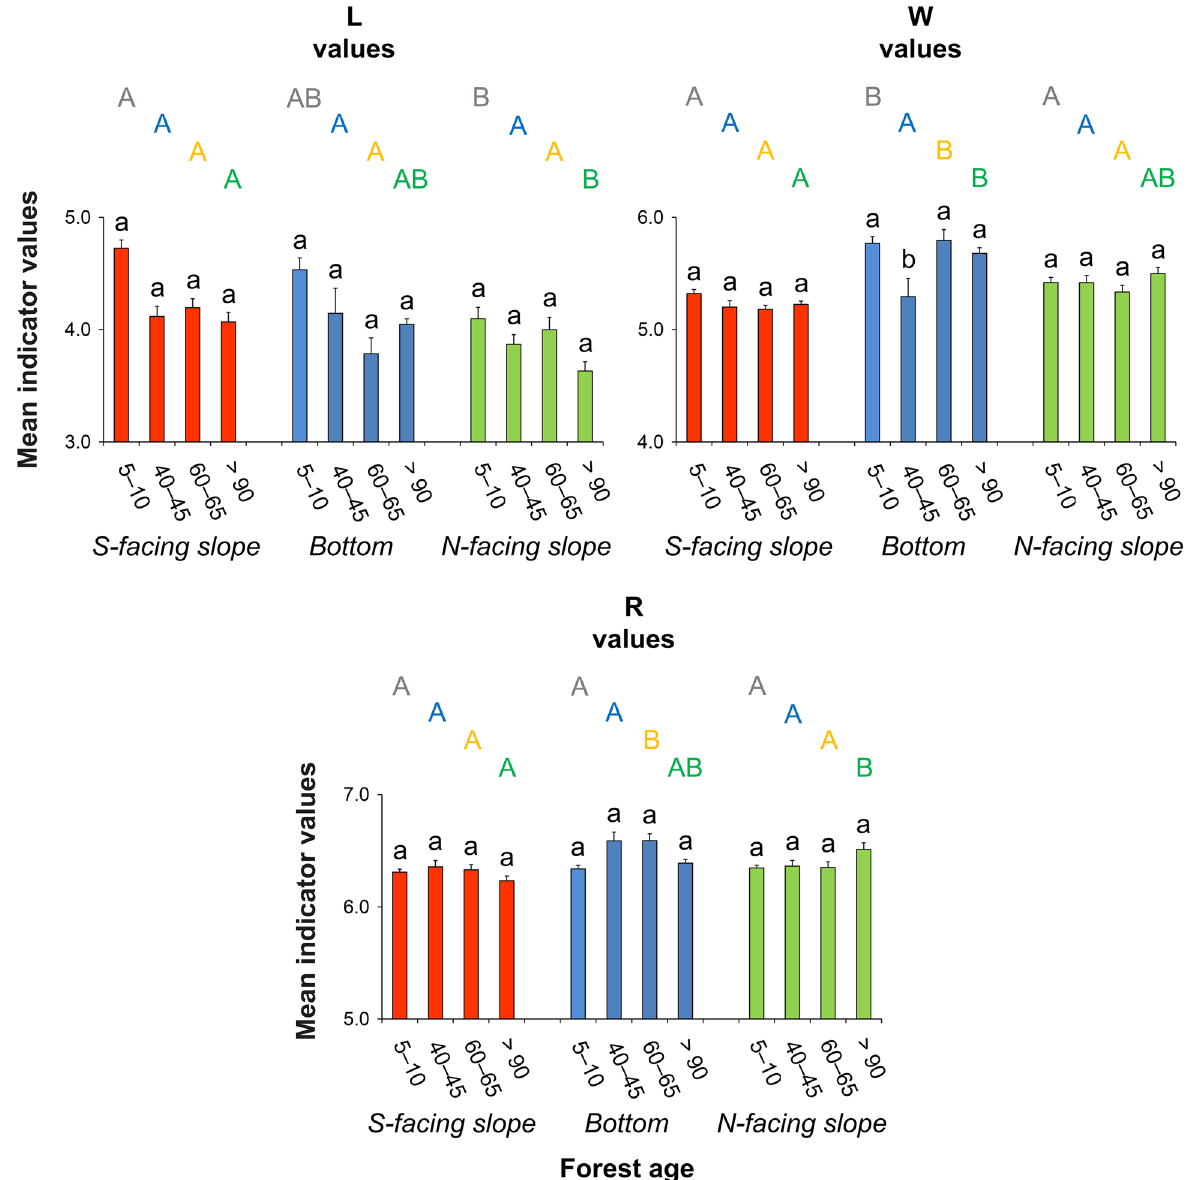
Fig. 10 Mean Ellenberg indicator values (L: light availability, W: soil moisture, and R: soil reaction) in the plots of topographic positions in dolines (south-facing slope, bottom, and north-facing slope) covered with different forest age classes (class 1: 5–10-year-old forest stands with mature forest patches, class 2: 40–45-year-old forests, class 3: 60–65-year-old forests, and class 4: more than 90-year-old forests) (mean (based on the LMMs with Bonferroni post hoc tests) are indicated by different lower case (a and b: between the same topographic positions of the different forest age classes, p < 0.05) and upper case (A and B in different colours: between the different topographic positions within a forest age class, p < 0.05) letters,